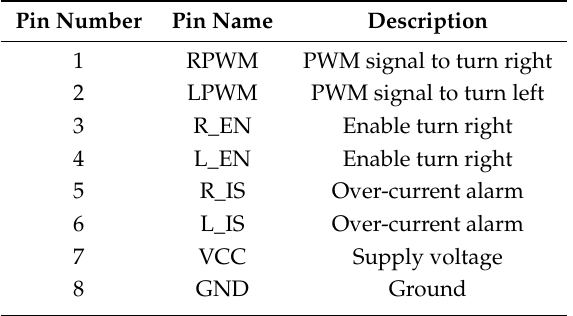
Table 5. Pin description of H-Bridge.